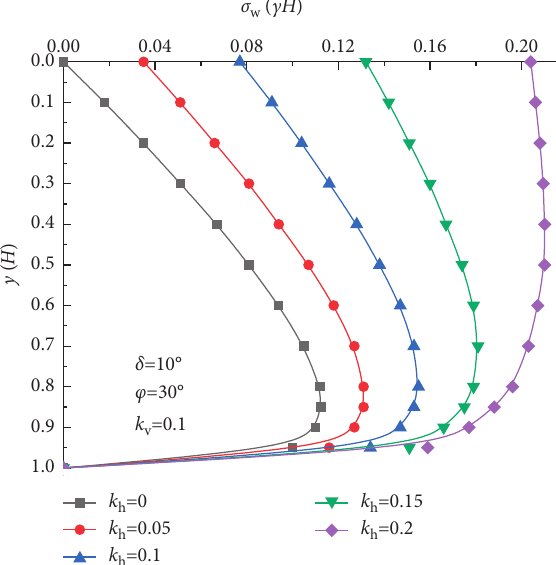
Figure 11: Influence of (k) h on seismic active earth pressure